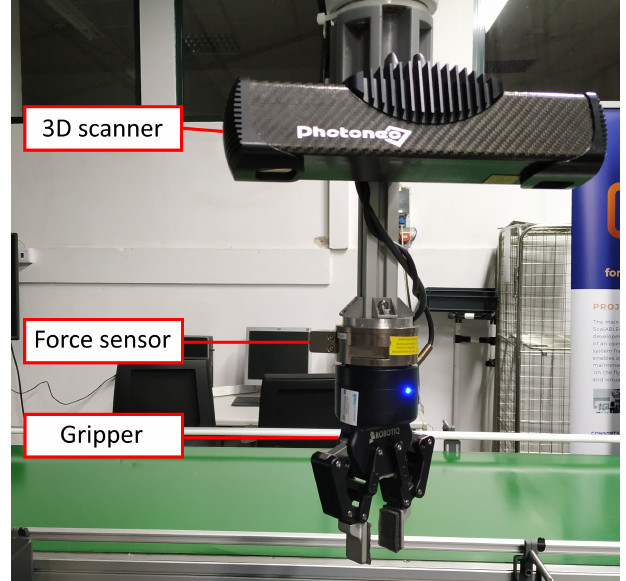
Figure 9. End-effectors attached to the flange.